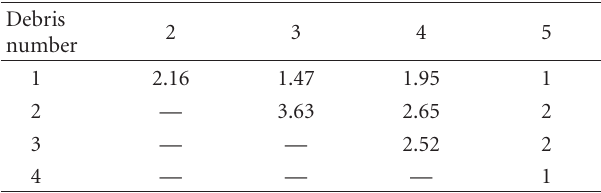
Table 4: Relative inclination change | Δ i | (deg) between orbit planes of the